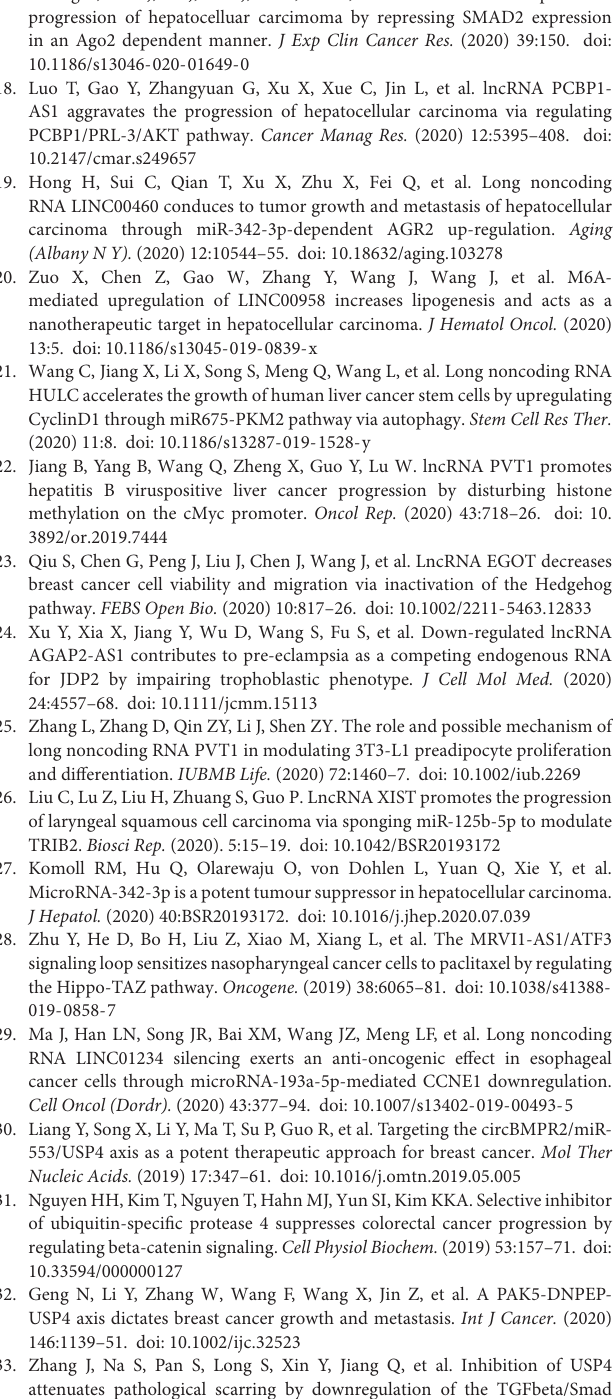
FIGURE S1 | Knockdown of LINC01234 significantly induced the apoptosis of HepG2 cells. The apoptotic HepG2 cells were examined by flow cytometry. FIGURE S2 | The melt curve plots of